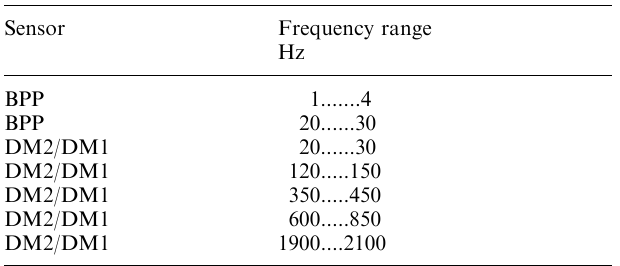
Table 3. Filters in MIF-M Sensor